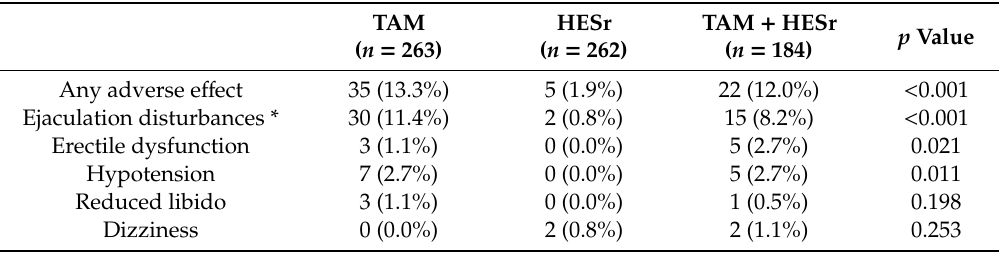
Table 4. Reported adverse e ff ects (AE) by treatment group (ITT analysis). Only AE with an incidence of ≥ 1% in any of the groups are